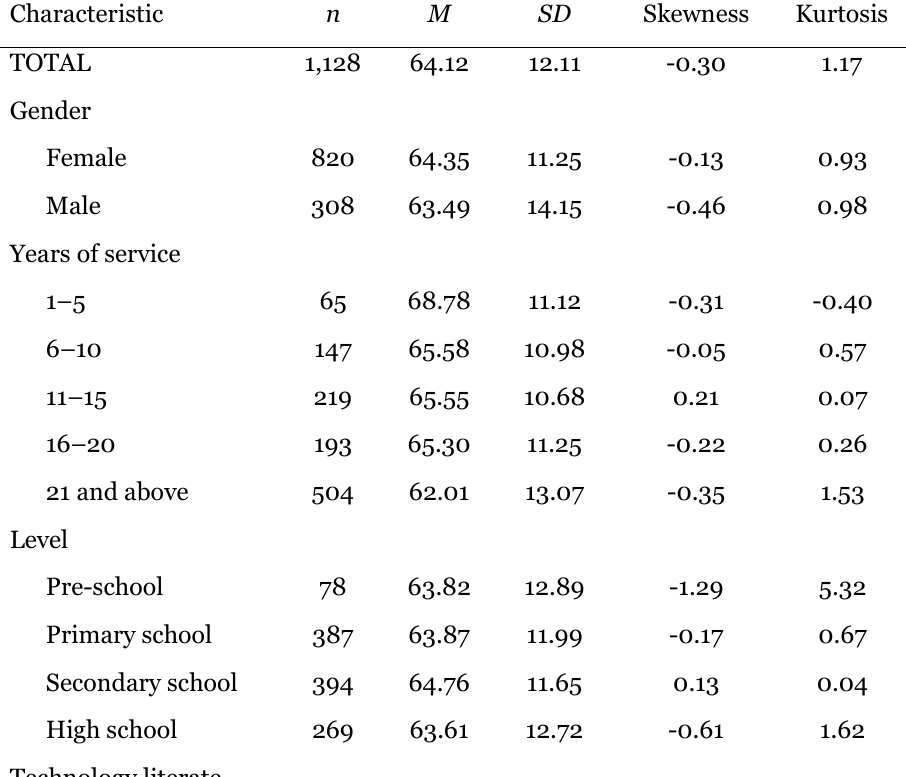
Descriptive Statistics (Standardized Scores Between